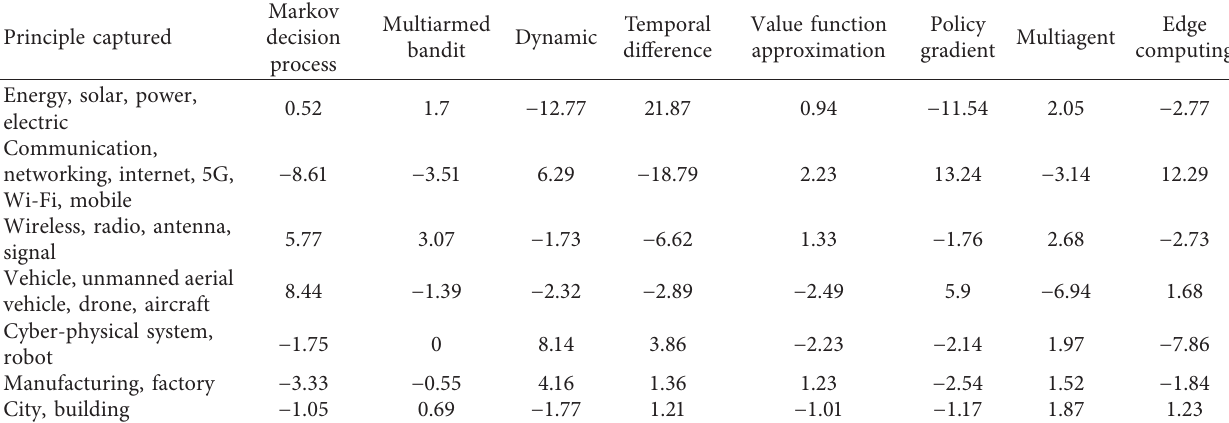
Table 4: χ 2 -test table of industrial field classes by RL method